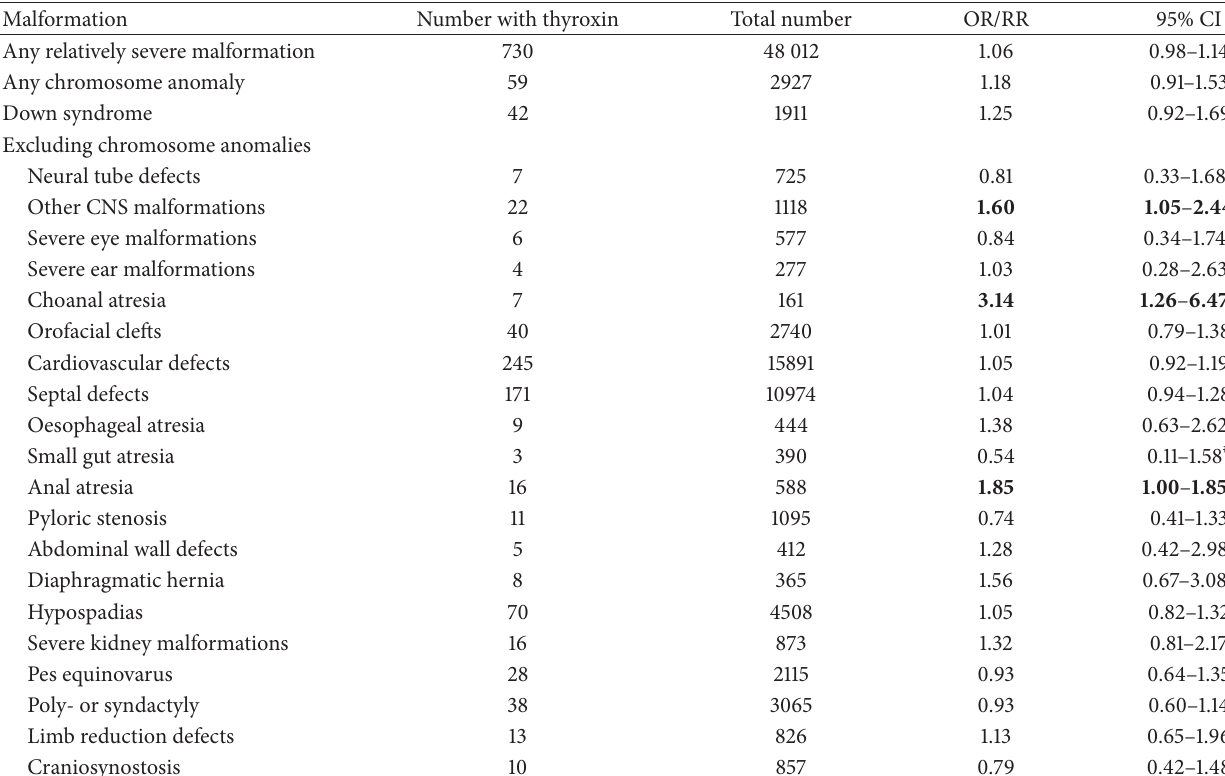
Table 2: Presence of congenital malformations in infants whose mothers reported the use of thyroxin in early pregnancy (𝑛 = 23 259) and in all infants born (𝑛 = 1567 736)